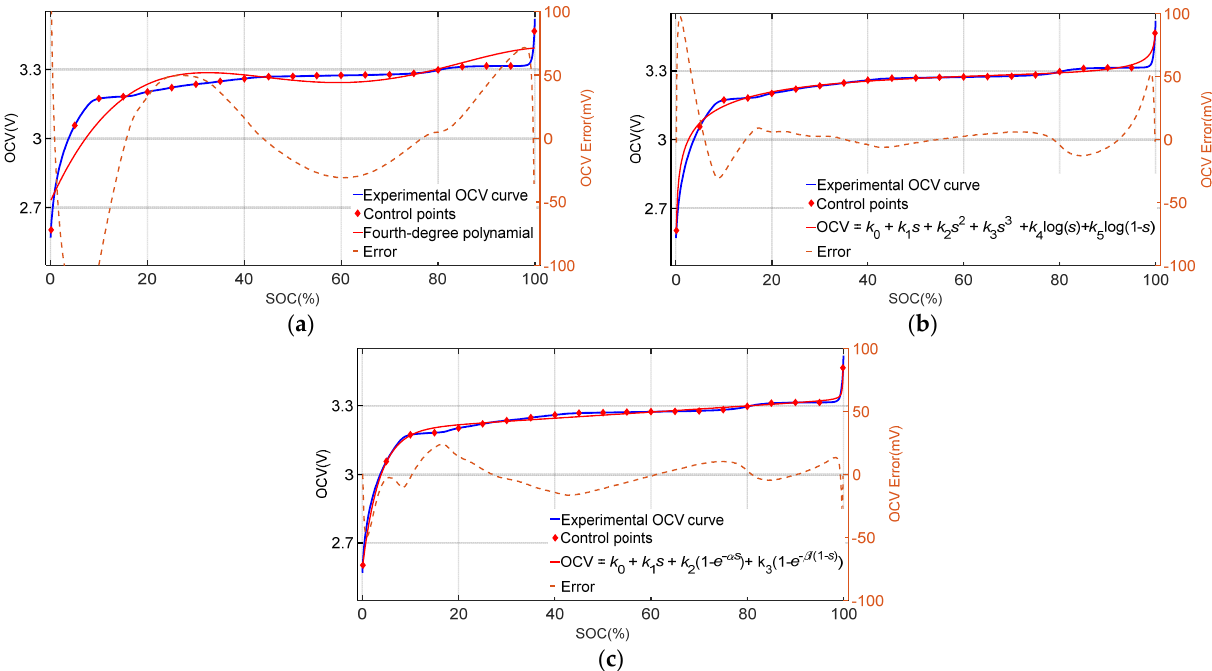
Figure 6. Conventional OCV models for LFP battery (21 control points, s denotes SOC, k 0, 1, 2, 3, 4 , α , β denote fit coefficients). ( a ) Fourth-degree polynomial. ( b ) Polynomial and logarithm. ( c ) Exponent and linear function.